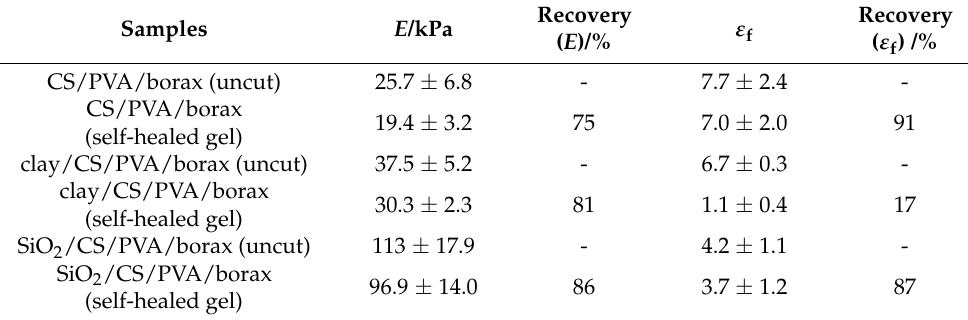
Table 2. Results of tensile measurements of self-healed